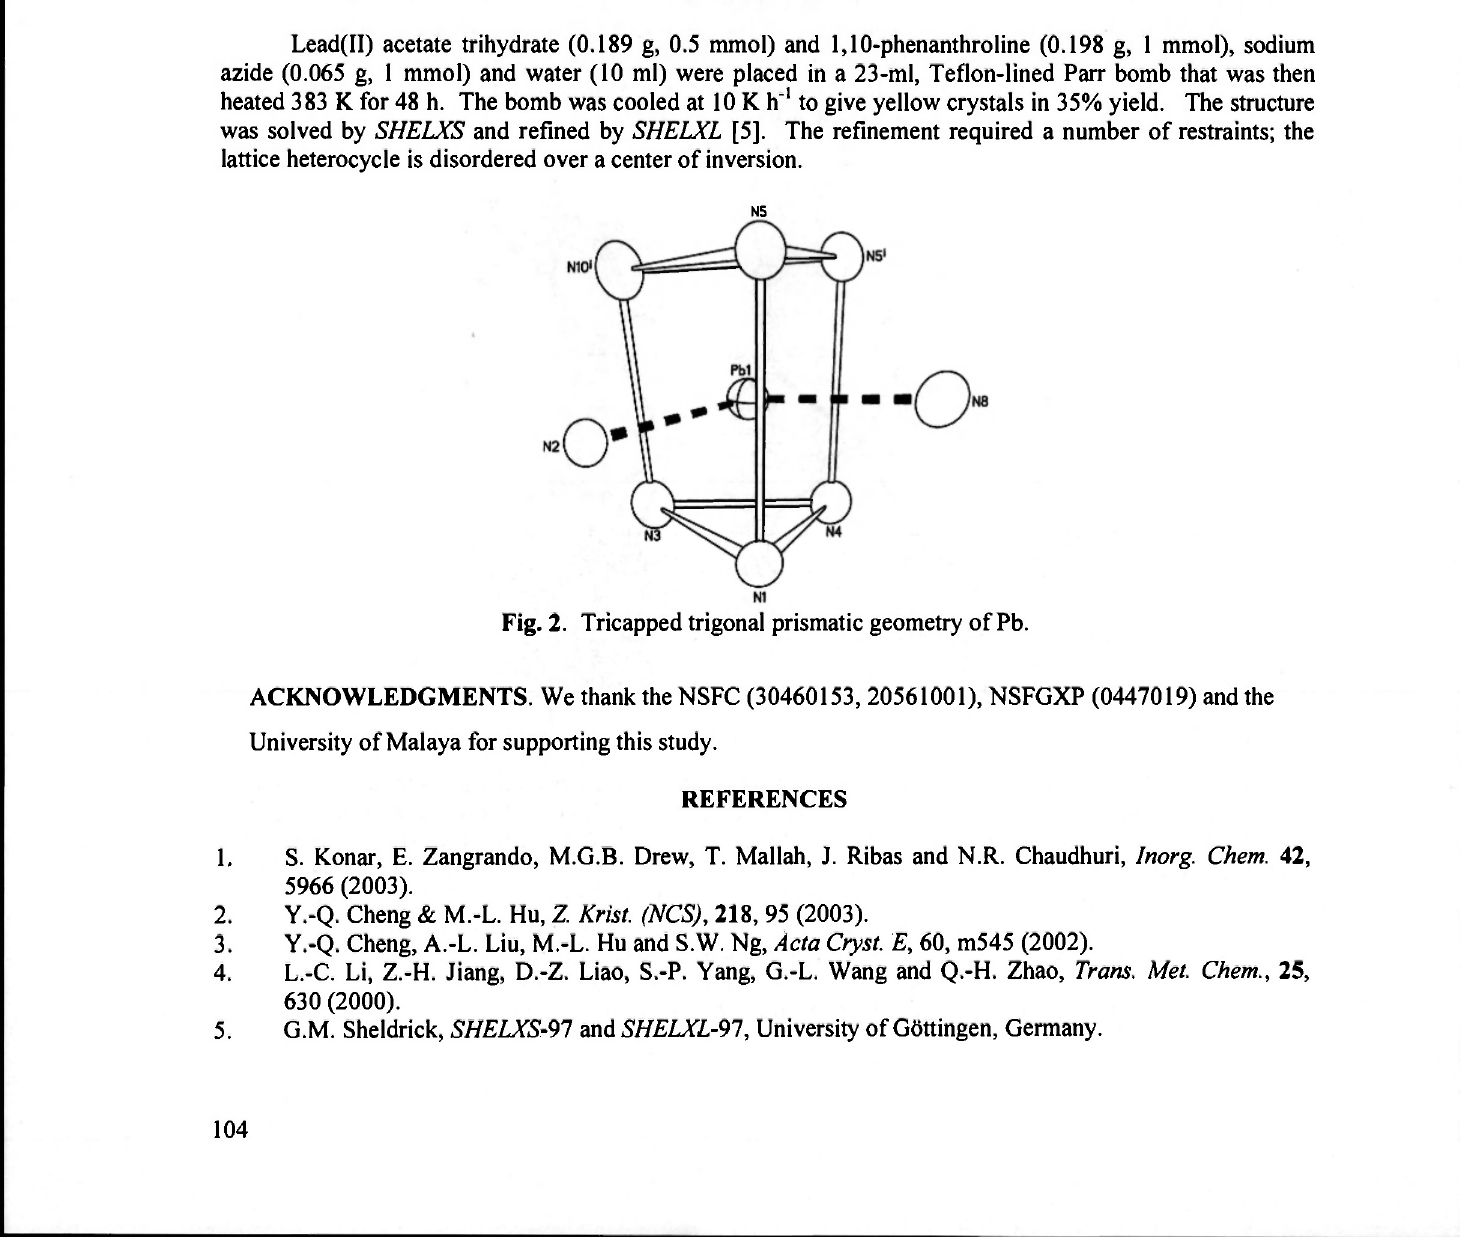
Fig. 2. Tricapped trigonal prismatic geometry of